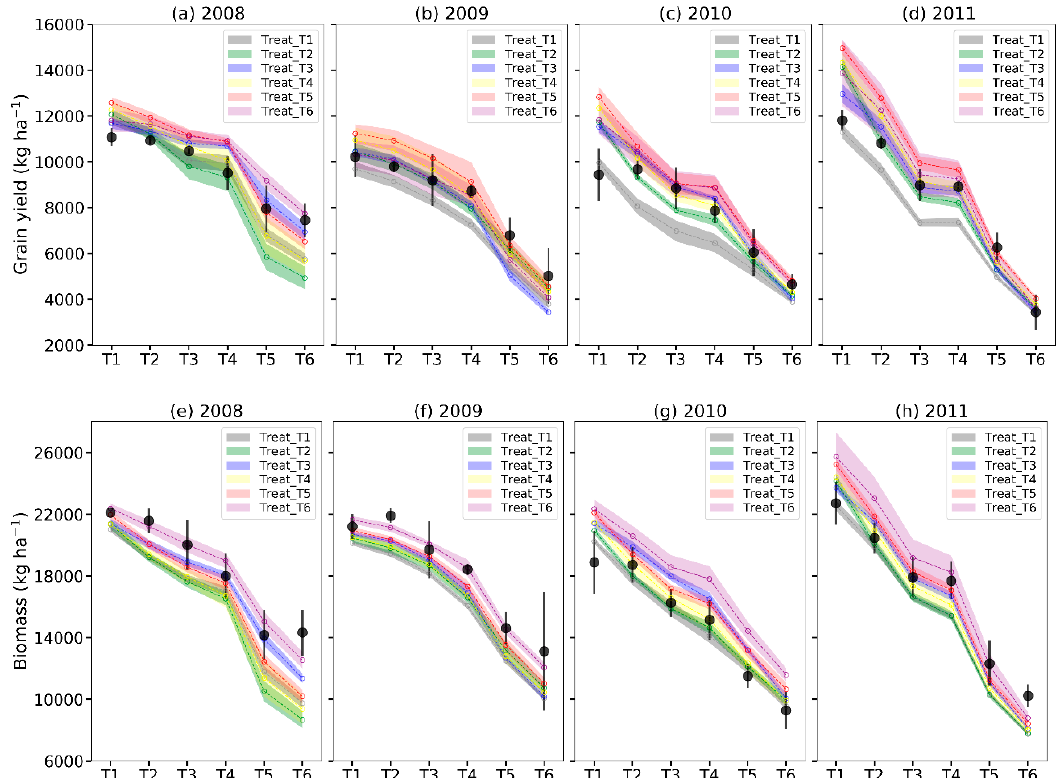
Figure 7. Experimental and simulated yield ( a – d ) and biomass ( e – h ) for Treat_T1 to Treat_T6 based on the Calibration-by-Treatment method (Table 3). The vertical bars and shaded areas are ±1 Standard Deviation (SD) around the mean for experimental and simulation data, respectively. The SD values was calculated based on the replicates for measured data and on the selected Φ cases for simulated data.